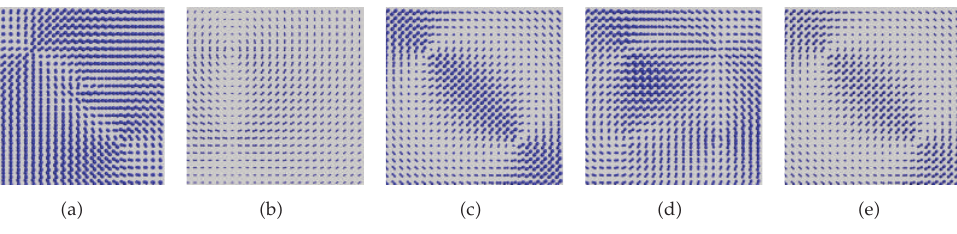
Figure 16: Resulting tensor field.